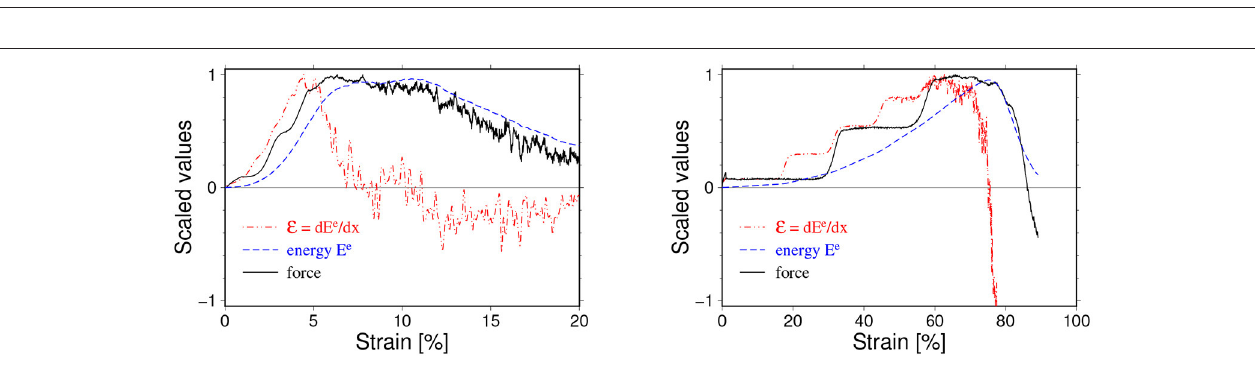
FIGURE 13 | Two examples of loading curves for semi-ductile breaking mechanisms with moderate (left) and strong amplitude acoustic waves generated and developing from the beginning of loading (see Figure 7 for the description). The wavelength of the acoustic waves for the case shown in the left panel is about 1/3 of critical strain and their presence manifest themselves in irregular increase of the loading force in the initial loading stage strain. In the case shown in the right panel neither the critical stress x c nor the maximum of energy absorption rate can be found with acceptable accuracy due to the strong acoustic waves. The particle-particle interaction parameters for the case shawn on left read: k n = 10 5 N/mm, b d = 0.05 mm and for the case shown on right k n = 10 2 N/mm, b d = 0.6